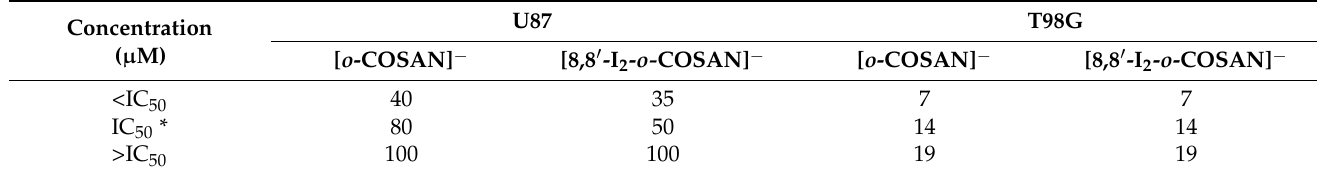
Table 3. Concentrations of metallabis(dicarbollide) compounds tested for the viability assay.